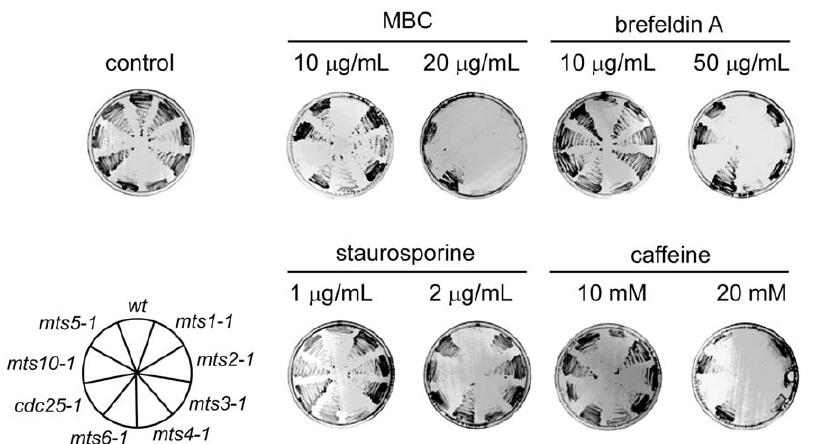
Figure 1. The mts mutants are multi-drug resistant. The indicated yeast strains (lower left panel) were streaked onto solid medium containing MBC, brefeldin A, staurosporine or caffeine at the shown concentrations and incubated for 48 hours at room temperature. On the control medium lacking drugs (upper left panel) all the strains grew. When the indicated drugs were added to the media the growth of wild type cells was compromised, while the mts mutants displayed resistance.